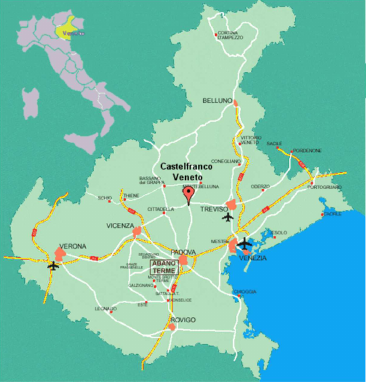
Figure 1: Geographic location of Castelfranco Veneto, Italy.